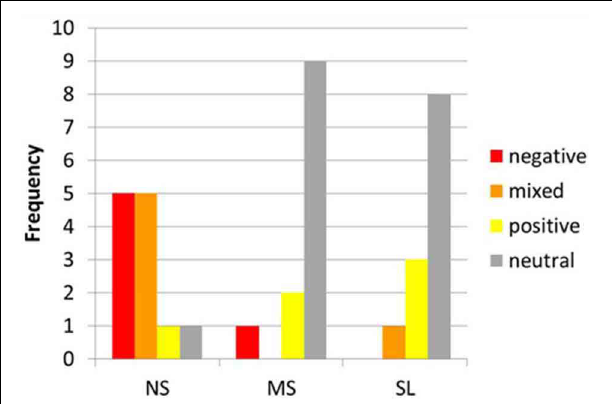
FIGURE 3 | 2D scalp maps of frequency bands with significant power PSC. 2D topographic representations of significant sensor-level power PSC for the NS vs. MS high-gamma 60–80Hz ( left ), and MS vs. SL beta 13–25Hz ( right ). Dots on the map represent sensors; color bar scale indicates PSC from 0.2 (dark red) to − 0.2 (dark